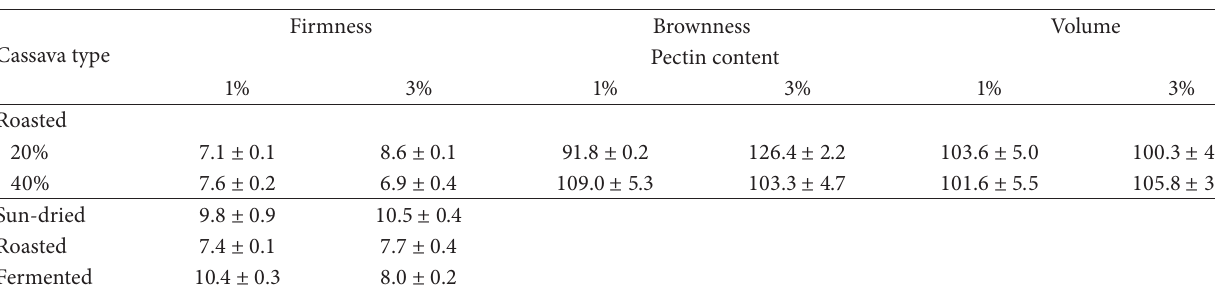
Table 4: Mean values of firmness (N), brownness index (BI), and volume (cm 3 ) of bread types made with roasted cassava and containing 1 or 3% pectin